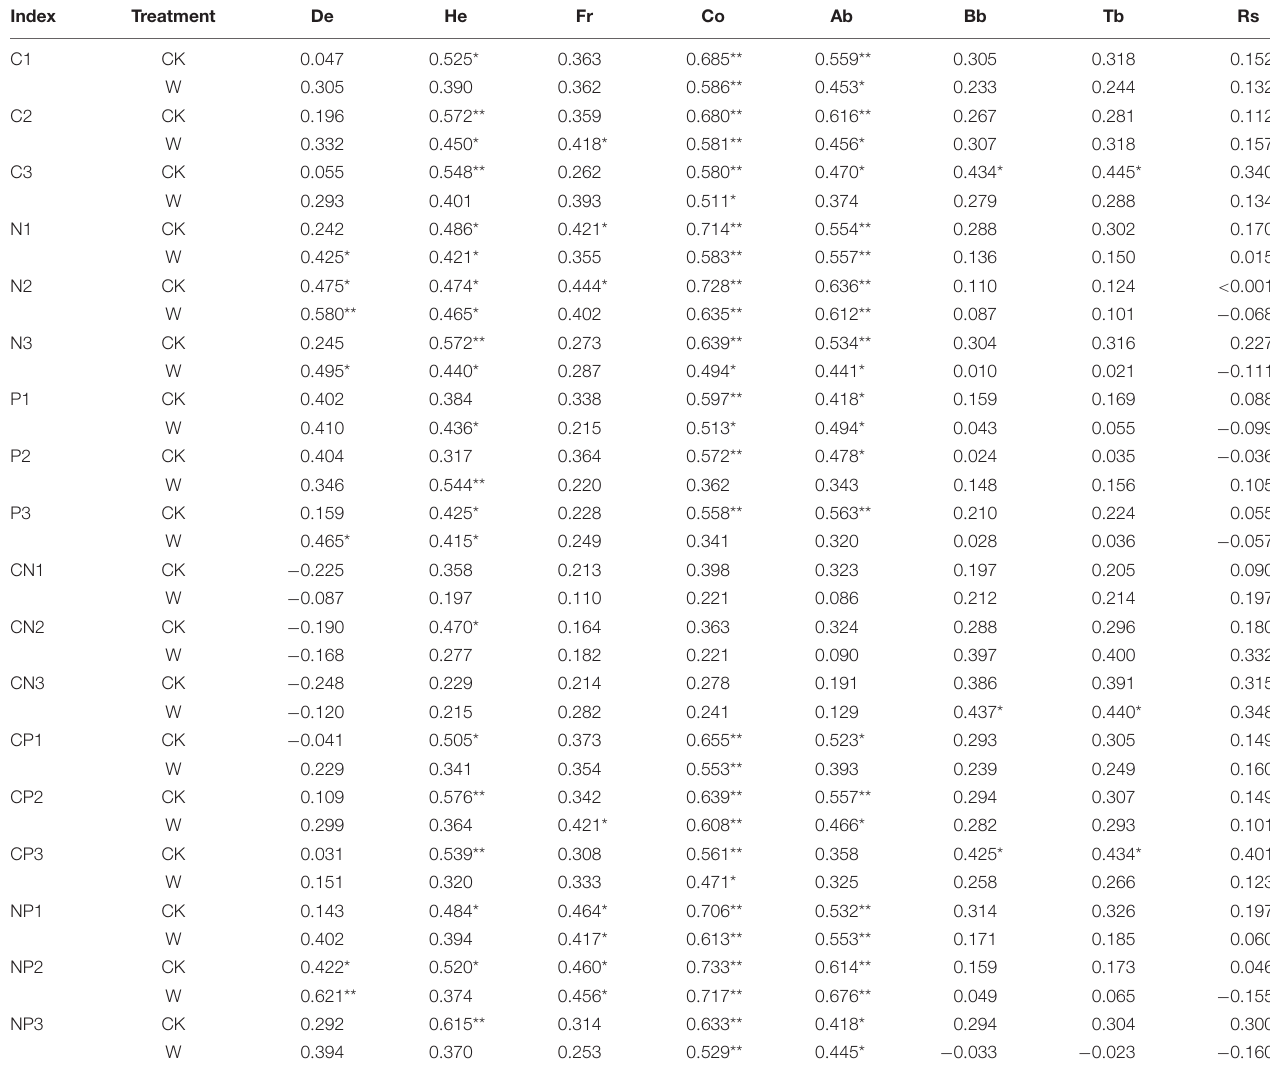
TABLE 4 | Effects of warming on the correlations of plant growth with the soil stoichiometric characteristics in an alpine meadow. Index